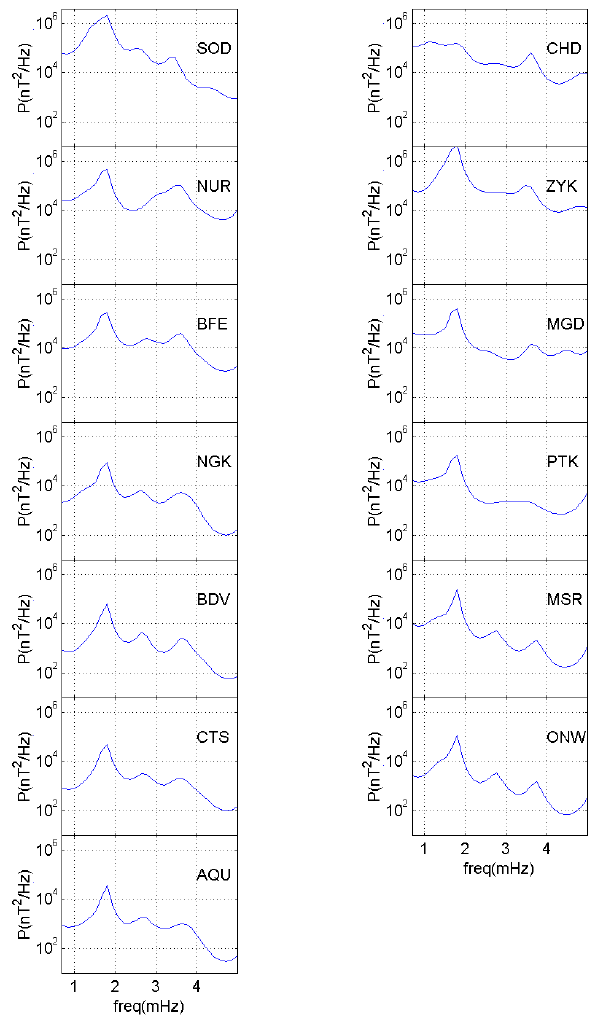
Fig. 4. Power spectra of the horizontal geomagnetic field H com- ponent in the time interval 07:00–09:00UT at the different